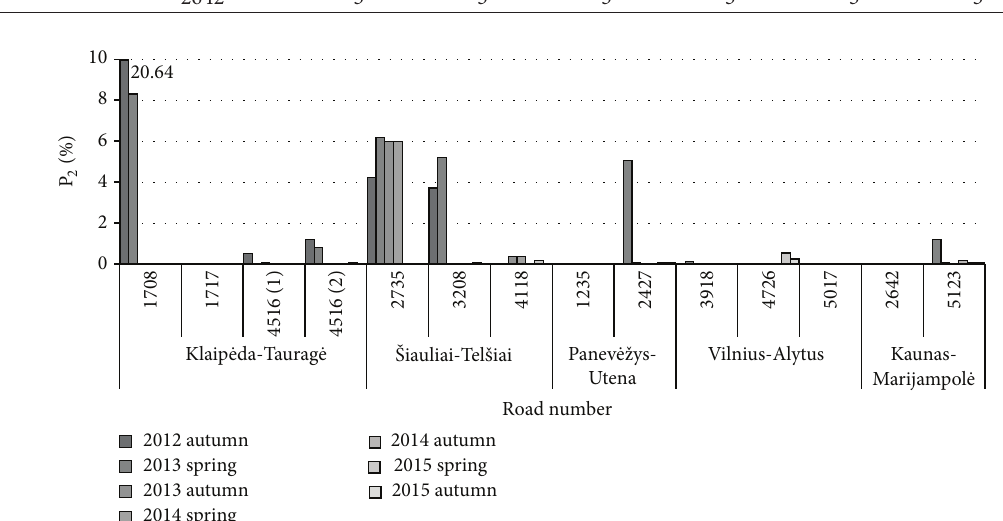
Figure 14: P 2 (scabbing, tearing, and longitudinal joint crack) on roads sections covered with double Otta